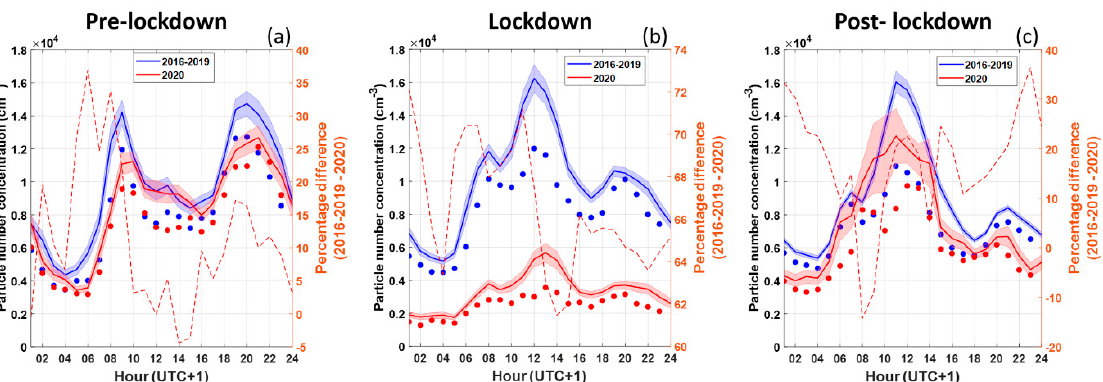
Figure 5. Diurnal cycle for ultrafine particle number concentration separated into three different phases ( a ) pre-lockdown, ( b ) lockdown, and ( c ) post-lockdown. The graphs show a comparison with the mirror period of 2016–2019. Circles in the graphs indicate the median values. On the right axis (dashed line) the relative percentage ratio between 2020 and the relative period for the three different phases is represented.